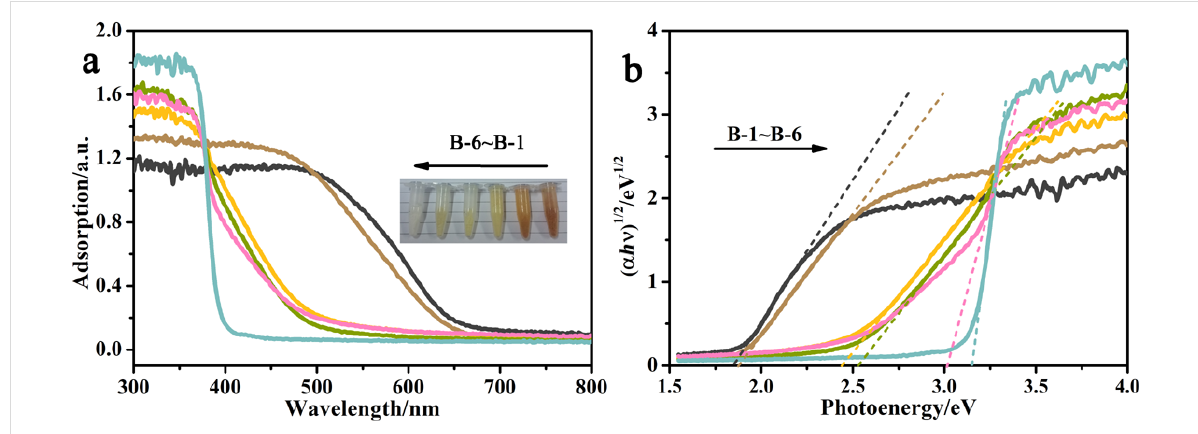
Figure 5: Optical properties of the as-prepared samples (a) UV–vis DRS spectra where the inset shows the physical color of the samples. (b) The plot of ( α h ν ) 2 vs photon energy ( h ν ).